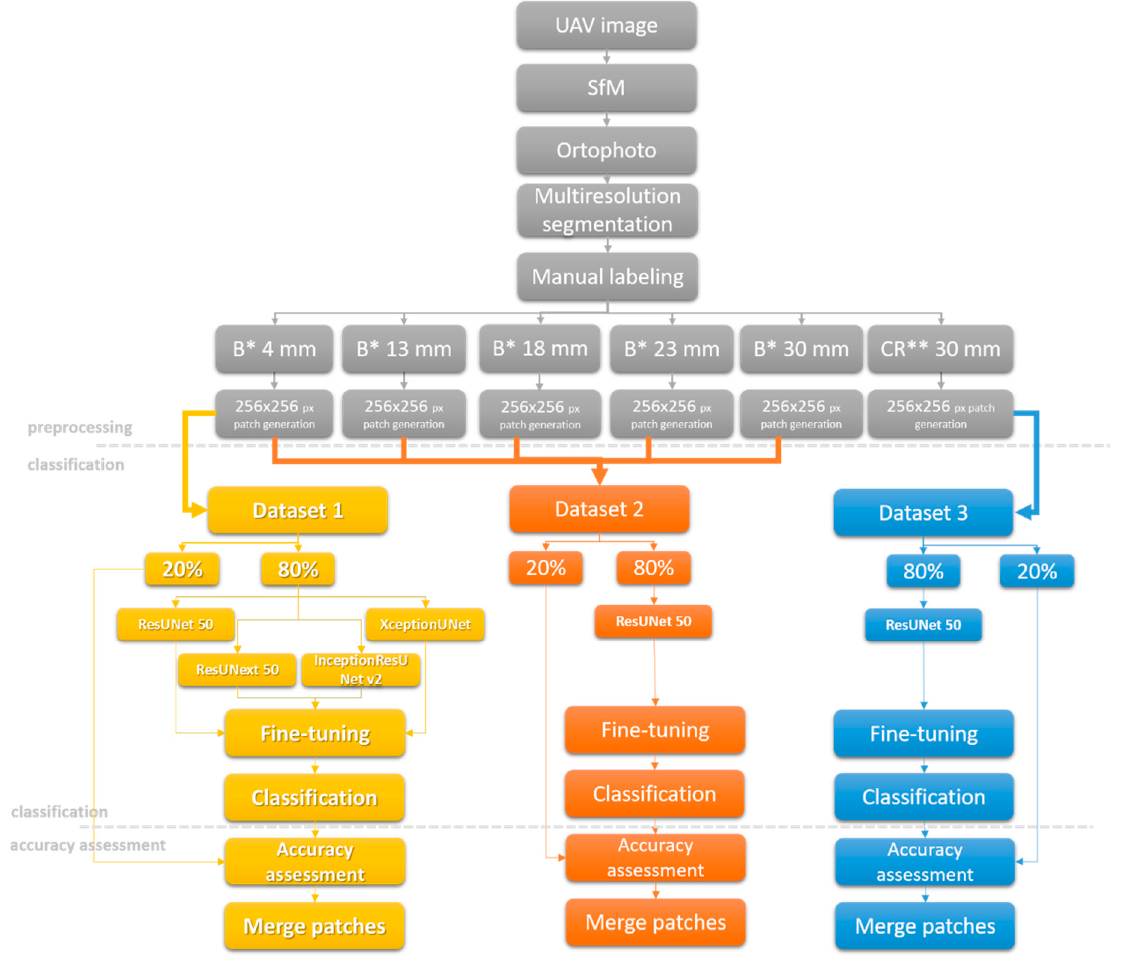
Figure 3. Workflow used in this study where “B*” and “CR**” correspond with the Balkana and Crna Rijeka dataset respectively. UAV = Unmanned Aerial Vehicles; SfM = Structure from Motion.